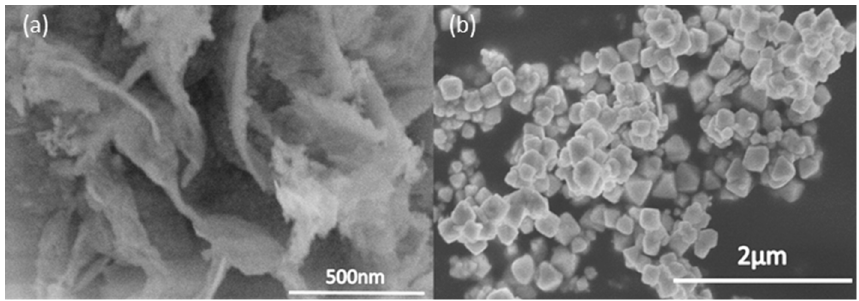
Figure 4. ( a , b ) High magnification of flower-like BiVO 4 and the results obtained under synthesis conditions of pH > 12.